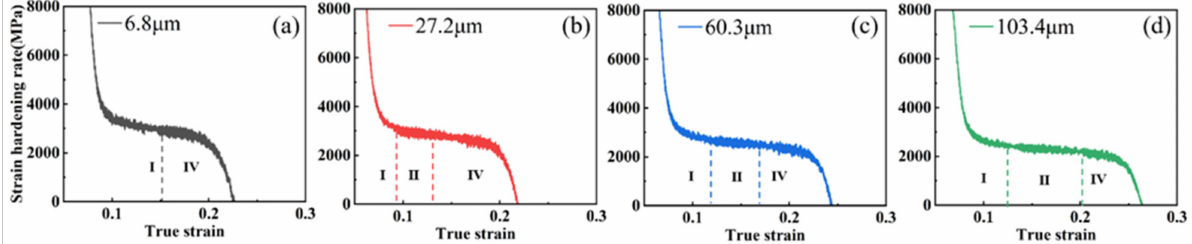
Figure 6. Work-hardening rate curves for each grain size sample at 30% reduction: ( a ) 6.8 µ m; ( b ) 27.2 µ m; ( c ) 60.3 µ m; ( d ) 103.4 µ